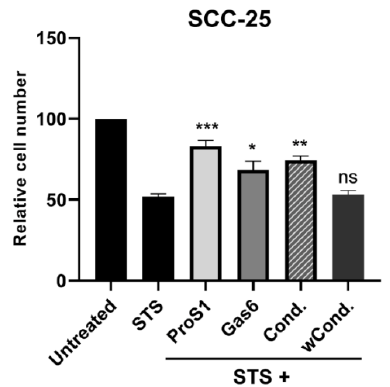
Figure 7. MTS assay showing the influence of vitamin K antagonism by warfarin on the functionality of natural ProS1 secreted by 786-0 cells. Apoptosis was induced by staurosporine (0.1 µM) in SCC-25 (responder) cells and the effects of co-incubation with exogenous TAM ligands for 20 h was measured, including conditioned medium from 786-0 (producer) cells collected after 48h incubation in 1% FBS media either with (wCond.) or without (Cond.) warfarin (1 µ g / ml). Data are mean ± SEM; ANOVA with Tukey’s multiple comparison post-hoc analysis; *** p < 0.001, ** p < 0.01, * p < 0.05 and ns, not significant, versus staurosporine (STS) (n = three separate